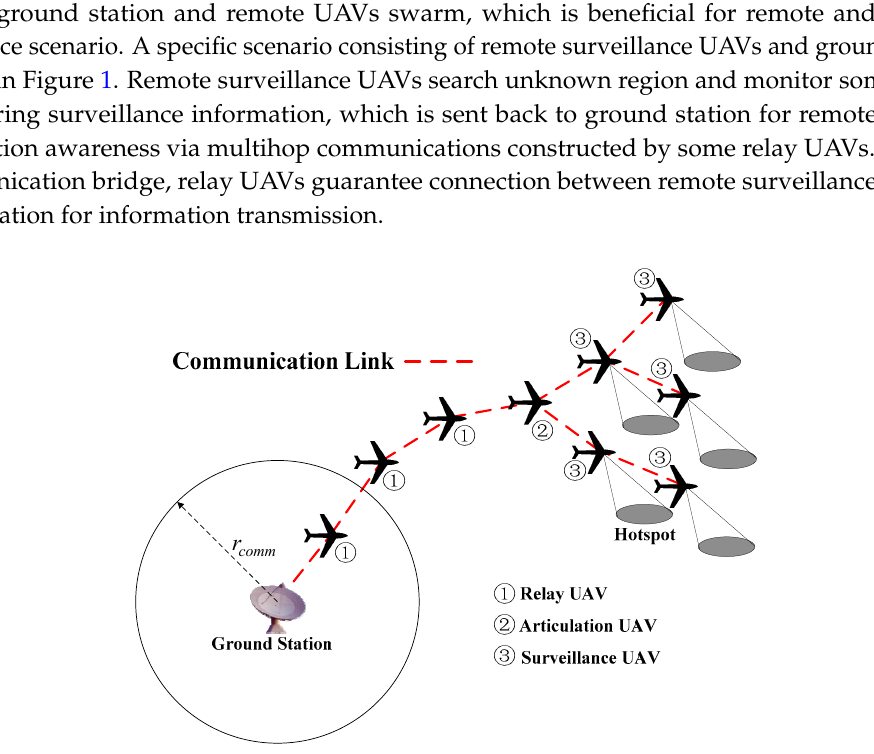
Figure 1. Multiple unmanned aerial vehicles (UAVs) cooperative surveillance with ground station.